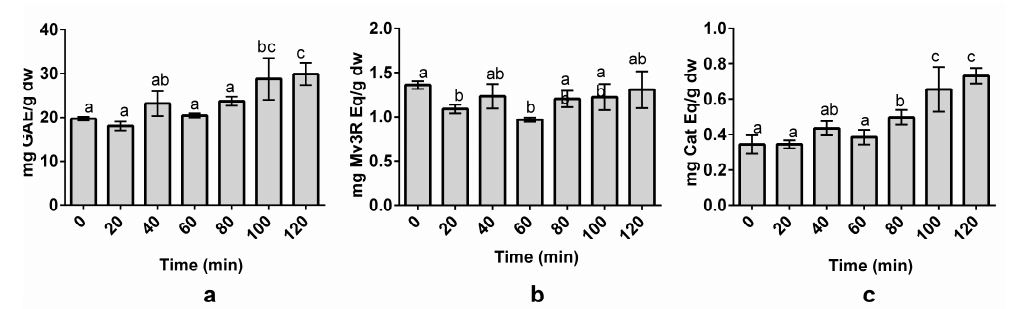
Figure 3. Effect of time on total phenolic content (TPC) ( a ), total anthocyanin content (TAC) ( b ), and total flavanol content (TFC) ( c ) of organic whole red Grenache grapes. The results are expressed as mg of phenolic equivalents per gram of dry weight (mg Eq/g dw) ± SD (n = 3). Letters represent significant differences (one-way ANOVA; p < 0.05). Abbreviations: gallic acid equivalents (GAE), malvidin-3- O -rutinoside (Mv3R), and catechin (Cat).